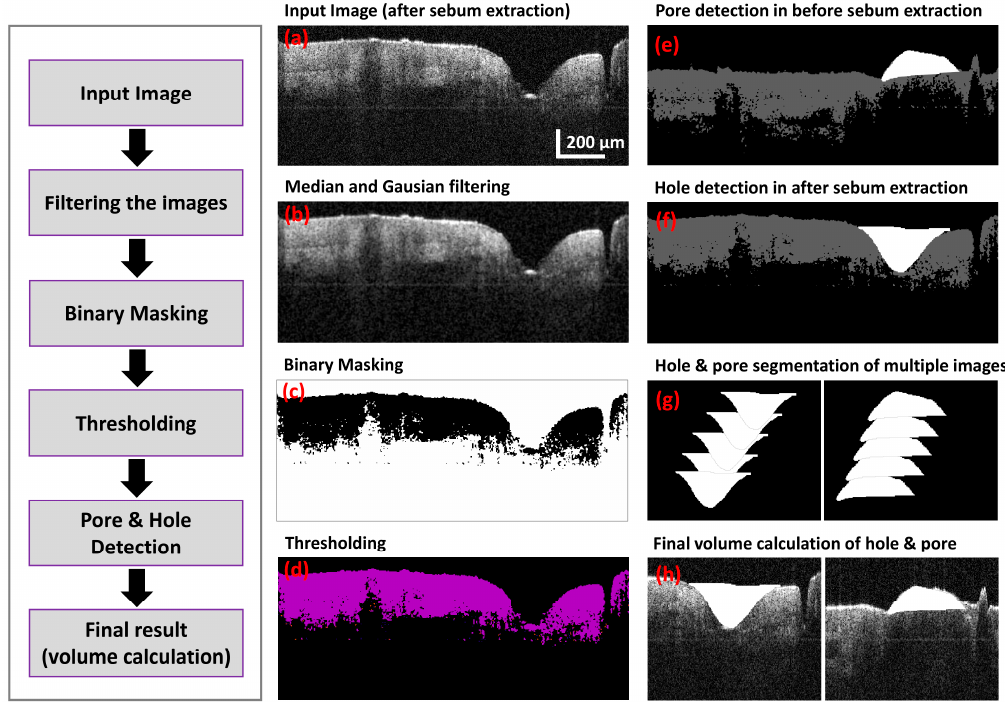
Figure 3. The segmentation algorithm for the quantitative analysis of the volume calculation before and after the sebum extraction.